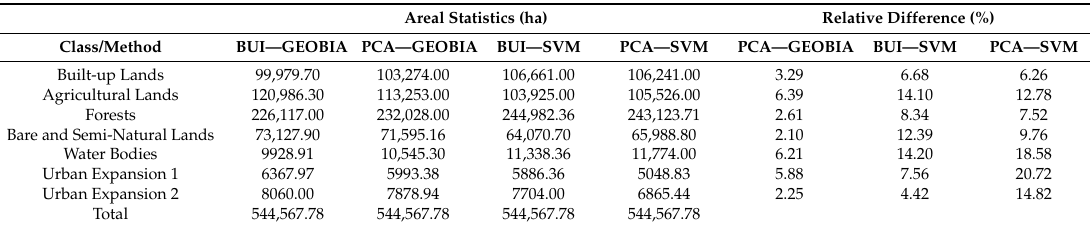
Table 6. Areal statistics and relative differences calculated from the classification